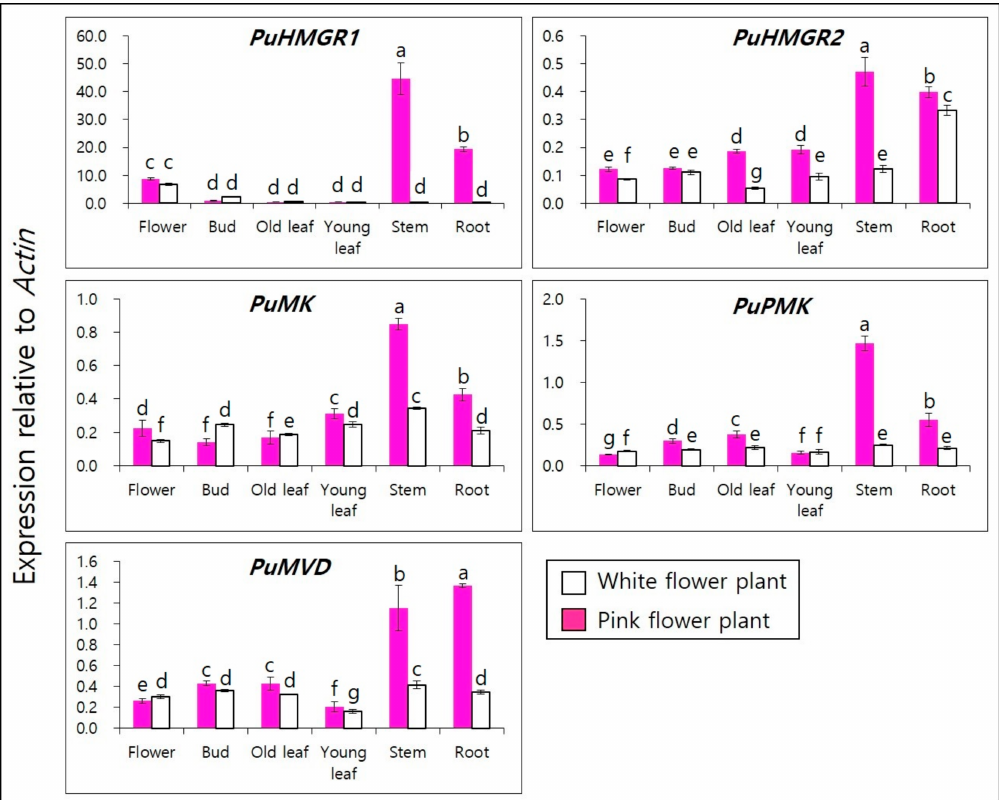
Figure 2. Expression levels of PuHMGRs, PuMK, PuPMK , and PuMVD in the flowers, buds, leaves (old and young), stem, and root of P. umbrosa . The height of each bar and the error bars show the mean and standard error, respectively, from three independent measurements. Values indicate means ± SD. Means with di ff erent letters are significant at p < 0.05 by Duncan’s Multiple Range Test